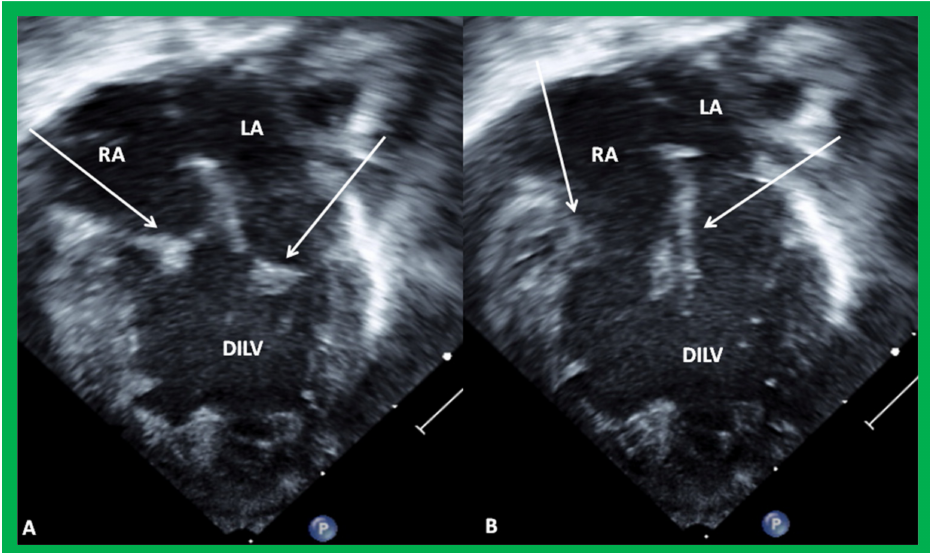
Figure 3. The 2D echo images from apical four-chamber projections of a child who was diagnosed to have double inlet left ventricle (DILV). ( A ) shows closed and ( B ) shows open atrioventricular valves as indicated by arrows. No evidence for a ventricular septum is seen. The right ventricle is not imaged in this projection (see Figure 4). Left atrium (LA) and right atrium (RA) are labeled. Reproduced from Reference [3].